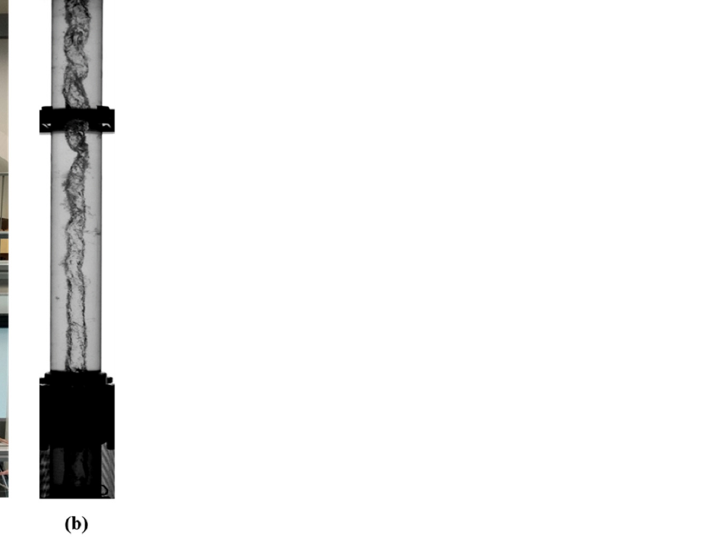
Figure 6. TU Delft Flow Test Facility ( a ) ERT position above the swirl element ( b ) High speed camera flow image, where the air core is present in the center of the device. The ERT shield can be seen in the bottom part of ( b